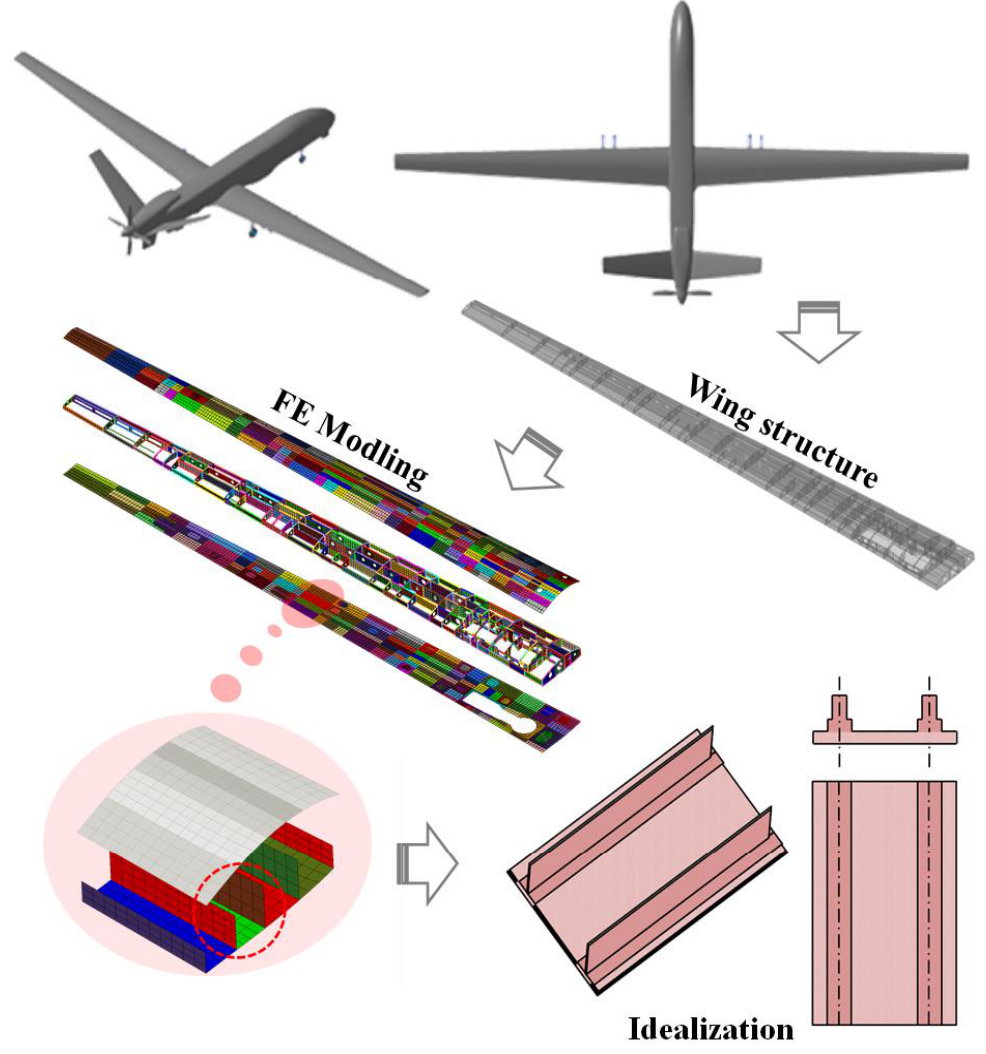
Figure 6. Structure configuration and optimization area of UAV slender wing.